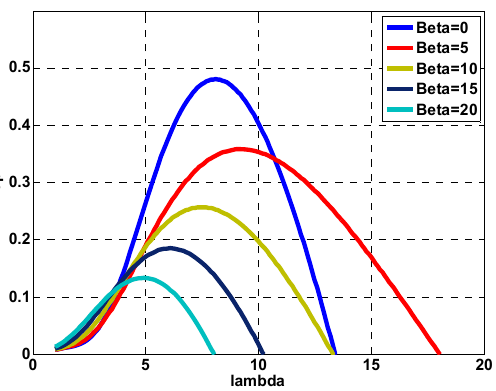
Figure 1. Performance coefficient curves.